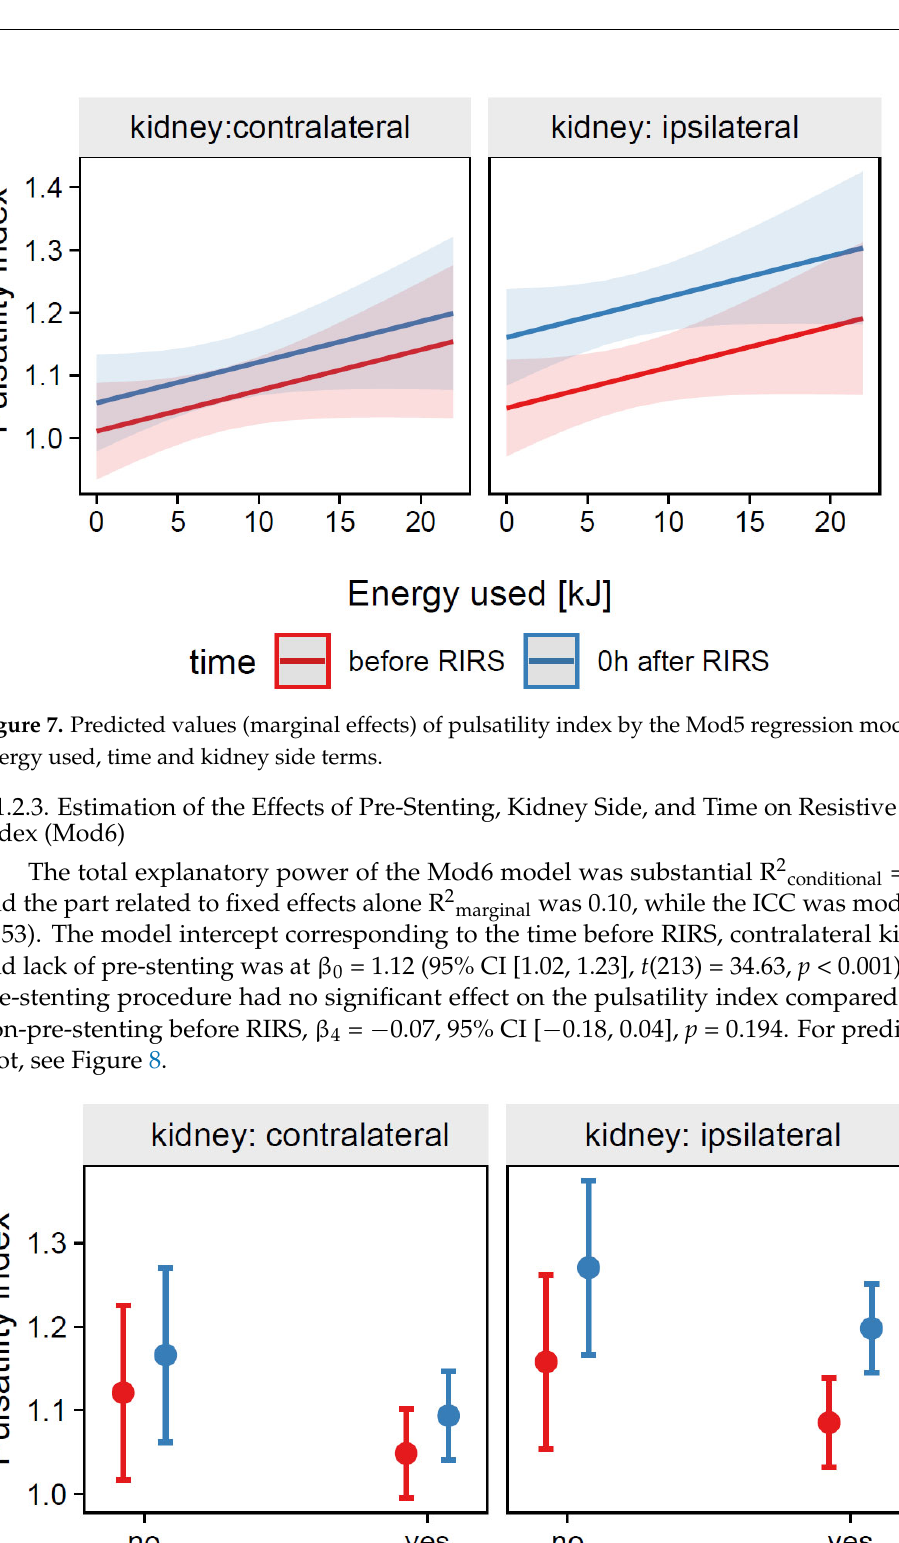
10 of 21 Figure 6. Predicted values (marginal e ff ects) of pulsatility index by the Mod4 regression model for mean stone volume, time and kidney side terms. 3.1.2.2. Estimation of the E ff ects of Energy Used, Kidney Side, and Time on the Resistive Index (Mod5) The total explanatory power of the Mod5 model was substantial R 2conditional = 0.58 and the part related to fi xed e ff ects alone R 2marginal was 0.11, while the ICC was moderate (0.53). The model intercept corresponding to the time before RIRS, contralateral kidney, and en-